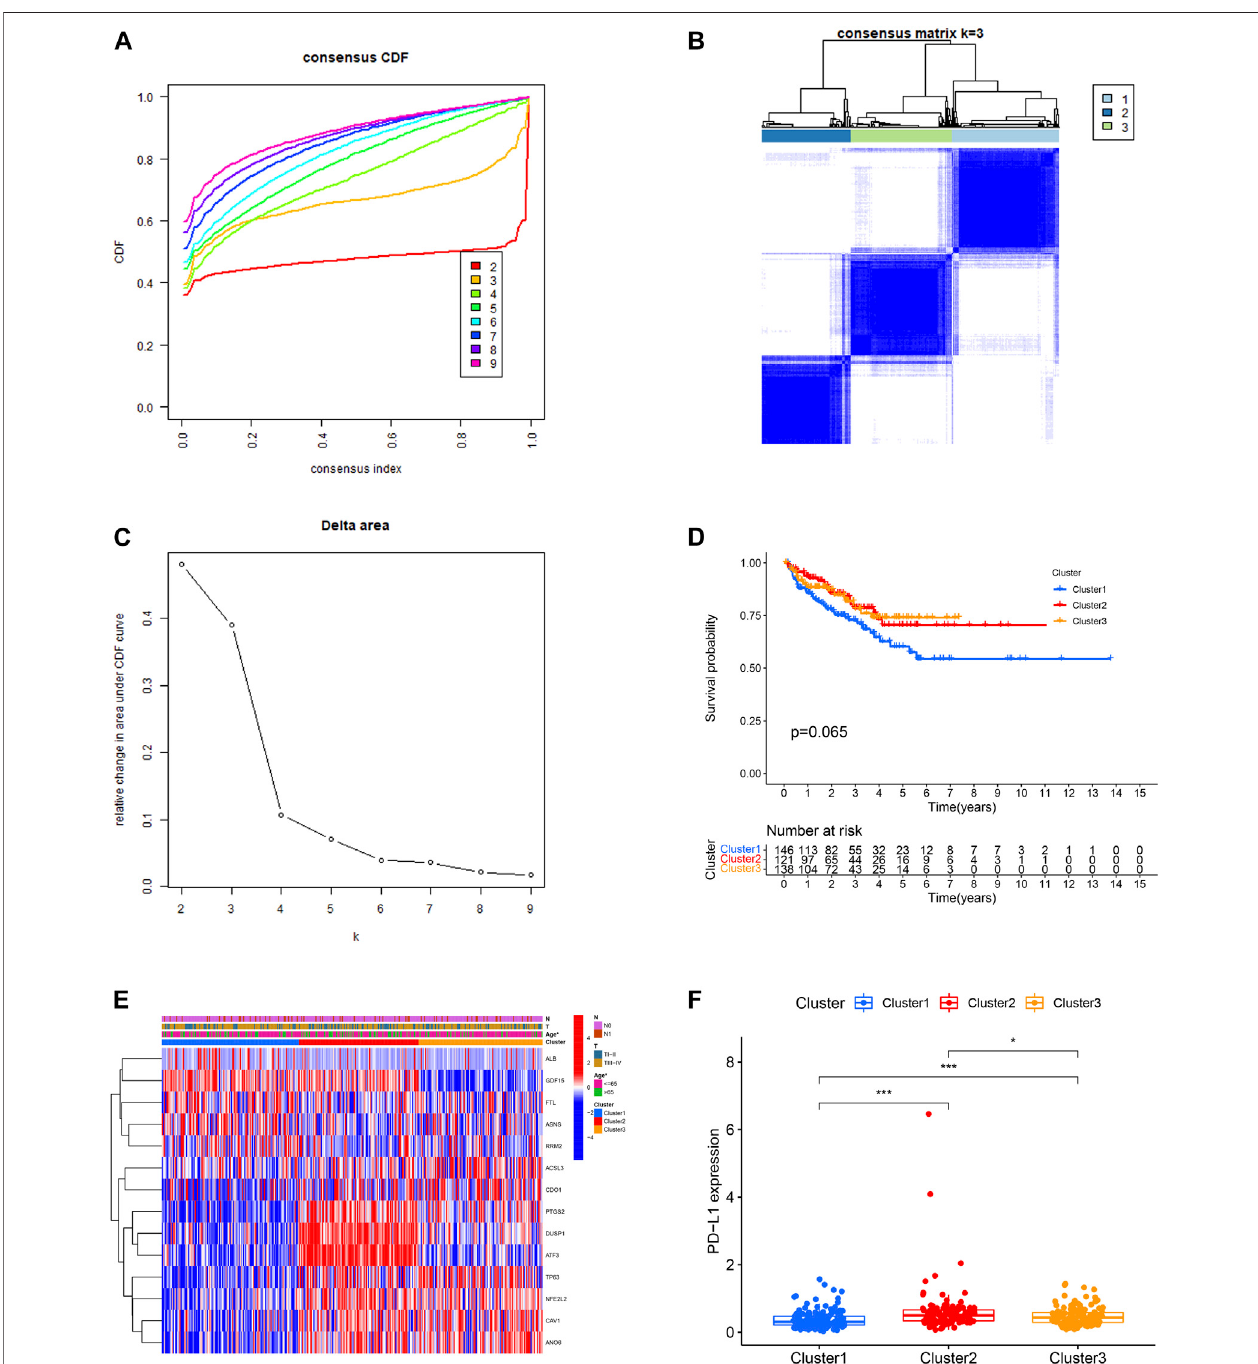
FIGURE 3 | Identi fi cation of three ferroptosis-related molecular clusters using consensus clustering analysis (A,B,C) . Comparison of biochemical recurrence free survival among these three clusters (D) . The correlation heatmap between the ferroptosis-related molecular clusters and clinicopathologic features (E) . The expression level of PD-L1 among these three clusters (F)